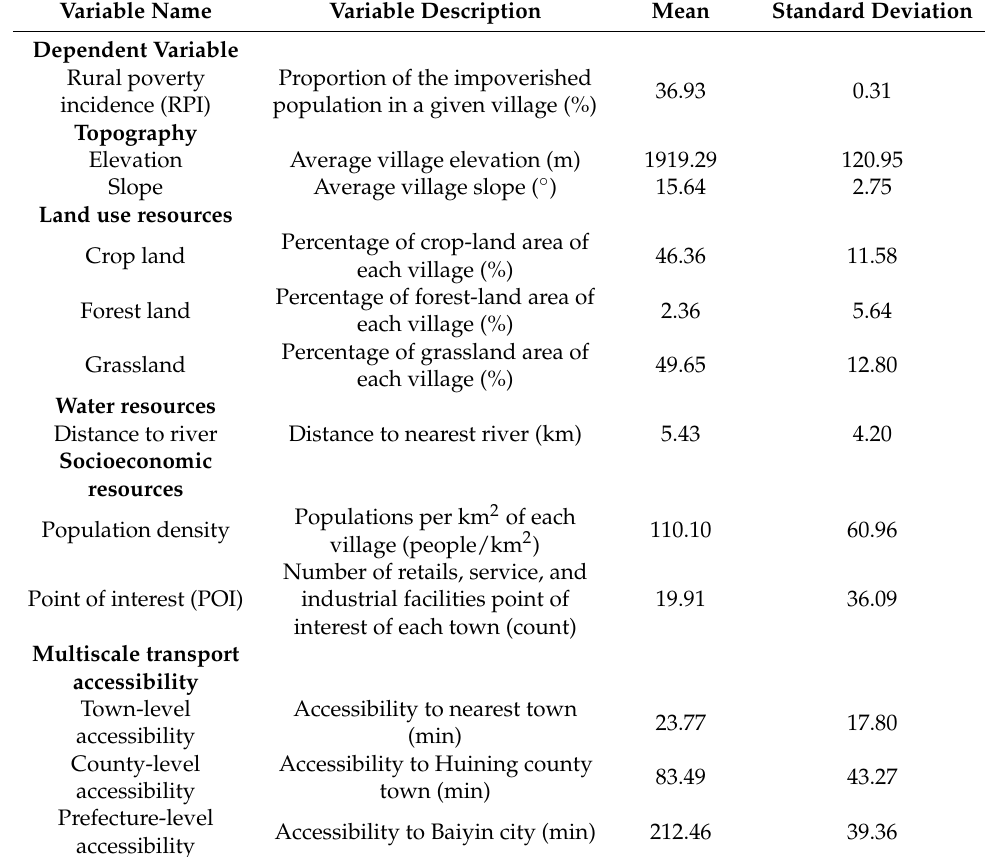
Table 1. Definition and descriptive statistics of